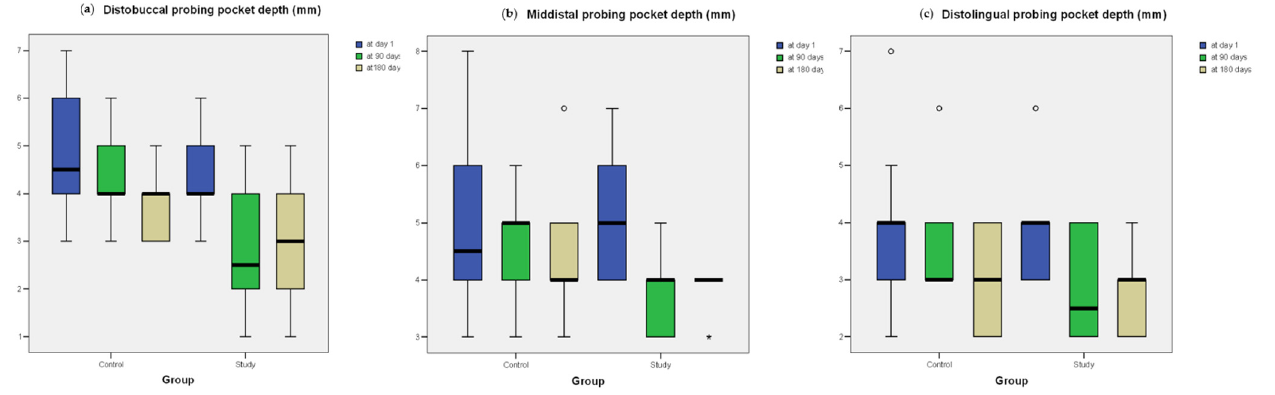
Figure 5. Box plots of probing pocket depth (PPD, mm) of the distal aspect of the experimental site and the control site at different follow-up intervals. ( a ) distobuccal PPD; ( b ) middistal PPD; ( c ) distolingual PPD. Outlier values at a distance from the median within 1.5 and 3.0 times the interquartile range (IQR) are plotted as circles. Extreme values at a greater distance from the median are plotted as asterisks.